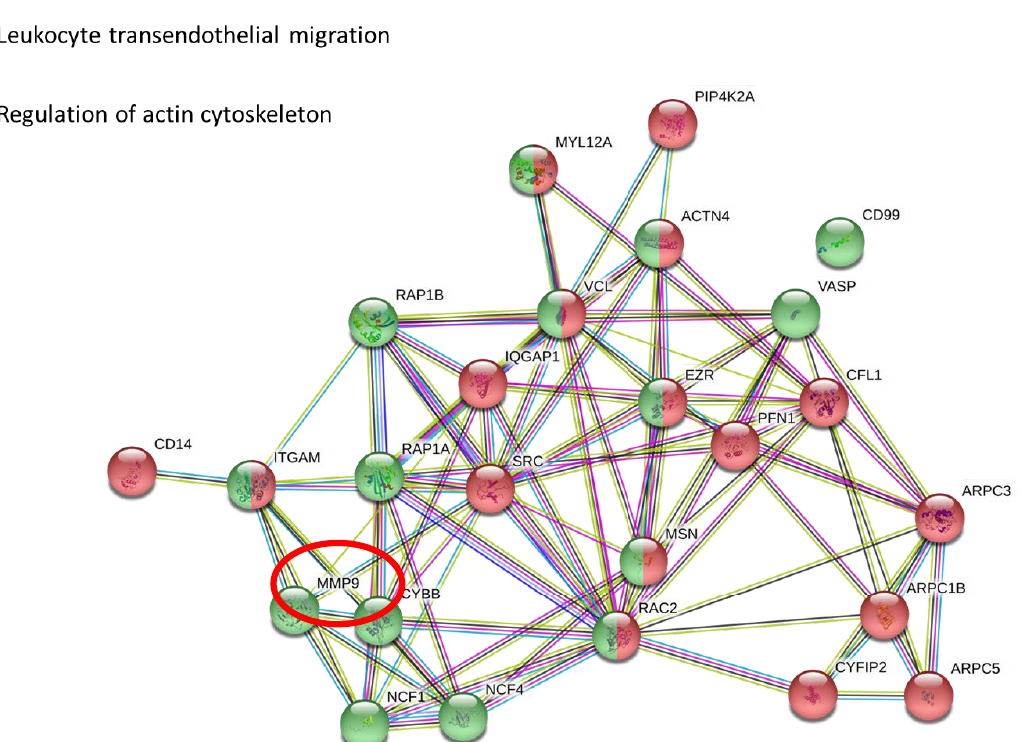
Figure 5. STRING network analysis of downregulated proteins in monocytes treated with VX770: the drug strongly altered leukocyte transendothelial migration and actin cytoskeleton function.